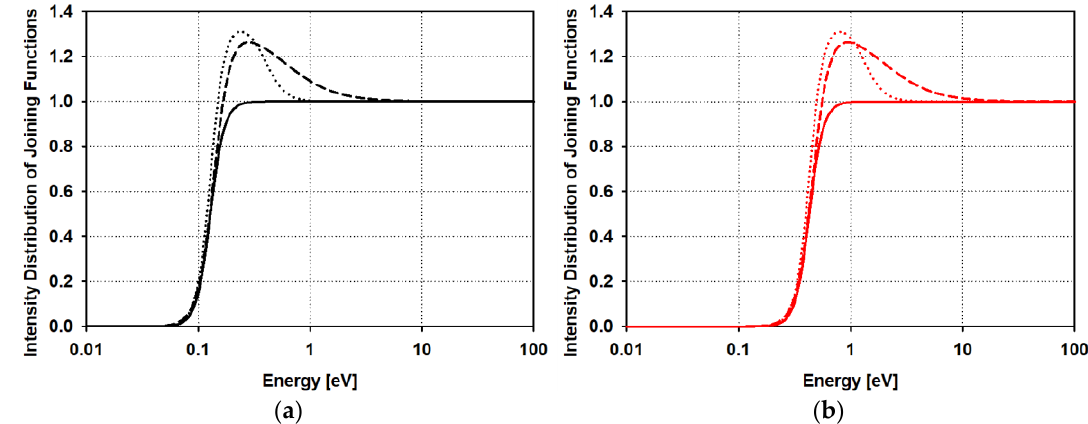
(solid line), ∆ W (dotted line), ∆ H (dashed line) for neutron temperatures ( a ) T n = 300 K; 2 4 4